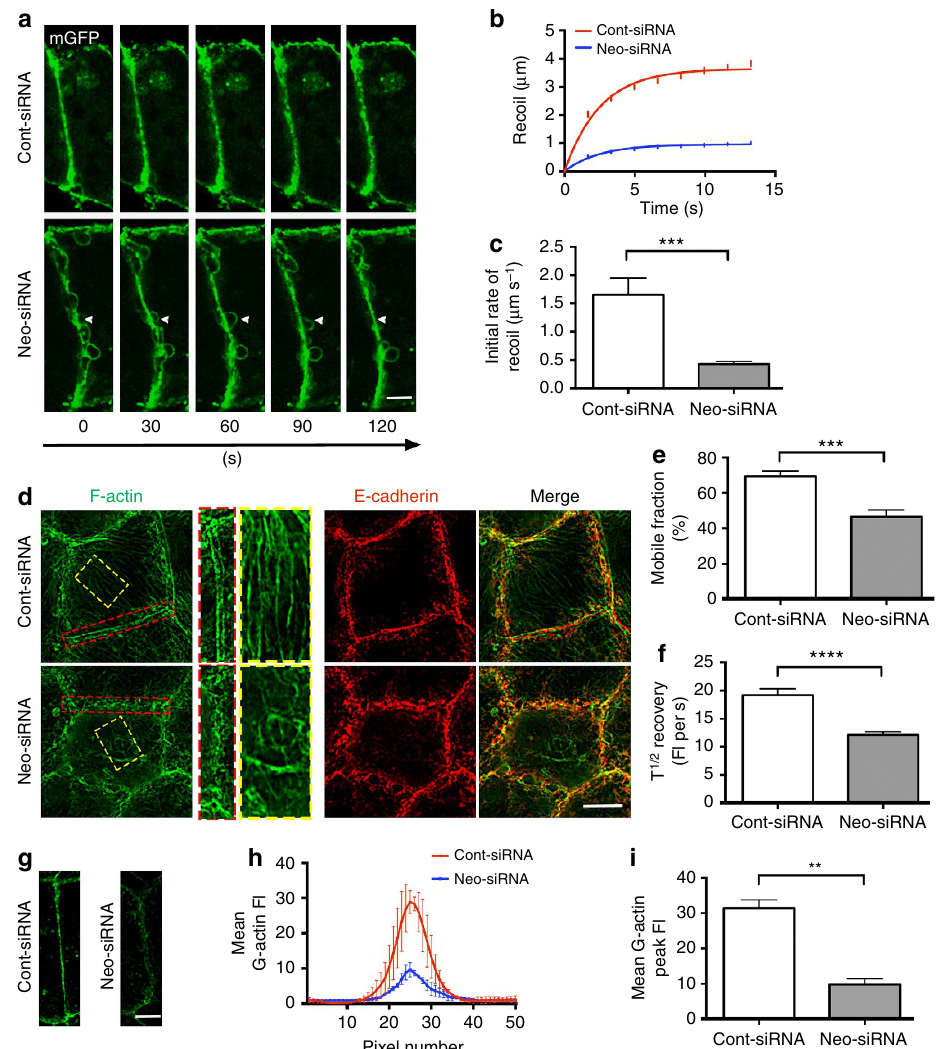
Figure 3 | Junctional tension is mediated by Neogenin-dependent perijunctional actin nucleation. ( a ) Time-lapse confocal micrographs (0–120s) of AJs in Caco-2 cells expressing mGFP (green) and Neo-siRNA (membrane protrusions, arrowheads). ( b , c ) Junctional tension was quantified using the laser nanoscissors technique. Loss of tension was demonstrated by the reduction in the extent of recoil towards the vertices and the rate of initial membrane recoil ( n 4 38 junctions; mean ± s.e.m.; *** P o 0.001, Student’s t -test). ( d ) Structured illumination micrographs show disruption of the actin cytoskeleton in Neo-siRNA cells (red box, junctional actin; yellow box, stress fibres; phalloidin, green; Ecad, red). FRAP analysis showed that loss of Neogenin reduced the mobile pool of F-actin at the AJ ( e ) and the time taken to reach 50% maximum fluorescence recovery (T 1/2 recovery) after bleaching ( f ) ( n 4 30, mean ± s.e.m., *** P o 0.001, **** P o 0.0001, Student’s t -test). ( g ) Fewer G-actin þ barbed ends (green) were seen adjacent to the AJ, demonstrating a reduction in actin nucleation in the absence of Neogenin. Line-scan analysis: ( h ) mean G-actin fluorescence intensity (FI) across AJs. ( i ) Mean G-actin